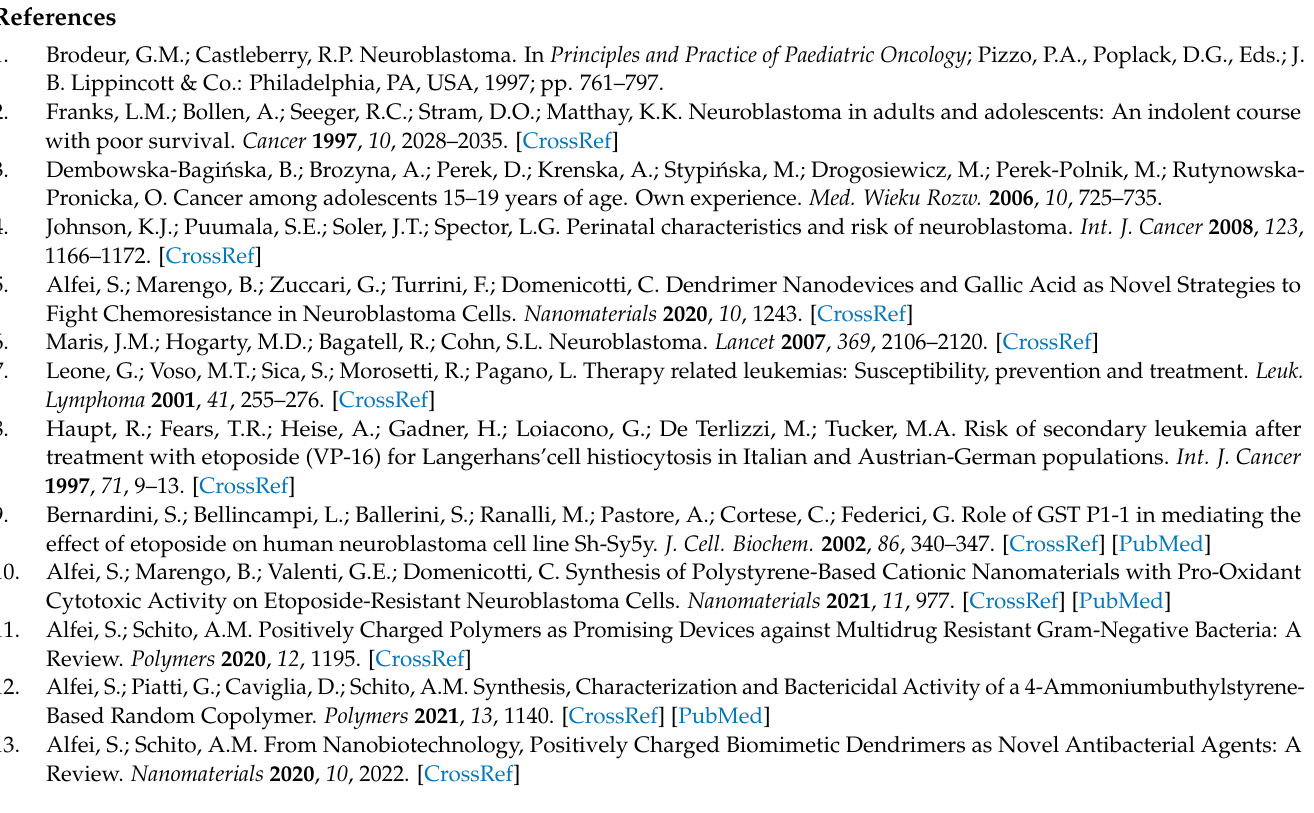
Figure S20: Dose-dependent cytotoxicity activity of CB1H at 24 h (purple), 48 h (blue), and 72 h (light blue) towards SHSY 5Y cells in the range 5–50 µ M; Figure S21: Dose- and time-dependent cytotoxicity activity of 4-HPR at 24 h, 48 h, and 72 h towards IMR-32 cells. Significance refers to control ( p > 0.05 ns; p < 0.05 *; p < 0.01 **; p < 0.001 ***); Figure S22: Dose- and time-dependent cytotoxicity activity of 4-HPR at 24 h, 48 h, and 72 h towards SHSY-5Y cells. Significance refers to control ( p > 0.05 ns; p < 0.05 *; p < 0.01 **; p < 0.001 ***); Figure S23: Dose-dependent cytotoxicity activity of 4-HPR at 24 h (blue), 48 h (orange), and 72 h (red) towards IMR-32 cells in the range 0.11–5 µ M. Concentrations over 5 µ M were not considered because cells viability did not significantly change further; Figure S24: Dose-dependent cytotoxicity activity of 4-HPR at 24 h (blue), 48 h (orange), and 72 h (red) towards SHSY 5Y cells in the range 0.1–15 µ M; Figure S25: Comparison between the IC50 values of CB1H, P7, CB1H-P7 and 4-HPR at 24 h, 48 h, and 72 h towards IMR-32 and SHSY 5Y cells; Figure S26: Comparison between the SI values of CB1H, P7, and CB1H-P7 at 24, 48 and 72 h towards IMR-32 and SHSY 5Y cells; Table S1: Concentrations of each sample administered to NB cells; Table S2: IC50 of CB1H, P7 and CB1H-P7 NPs towards IMR-32 NB cells and normal human keratino- cytes (HaCaT) at 24-, 48- and 72-hours exposition and their SI values; Table S3: IC50 of CB1H, P7 and CB1H-P7 NPs towards SHSY 5Y NB cells and normal human keratinocytes (HaCaT) at 24-, 48- and 72-hours exposition and their SI values; Table S4: Main characteristic of BBB4-G4K NPs [16]; Table S5: